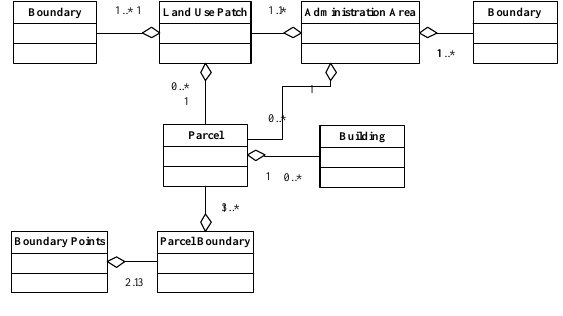
Figure 2. Urban cadastral data model